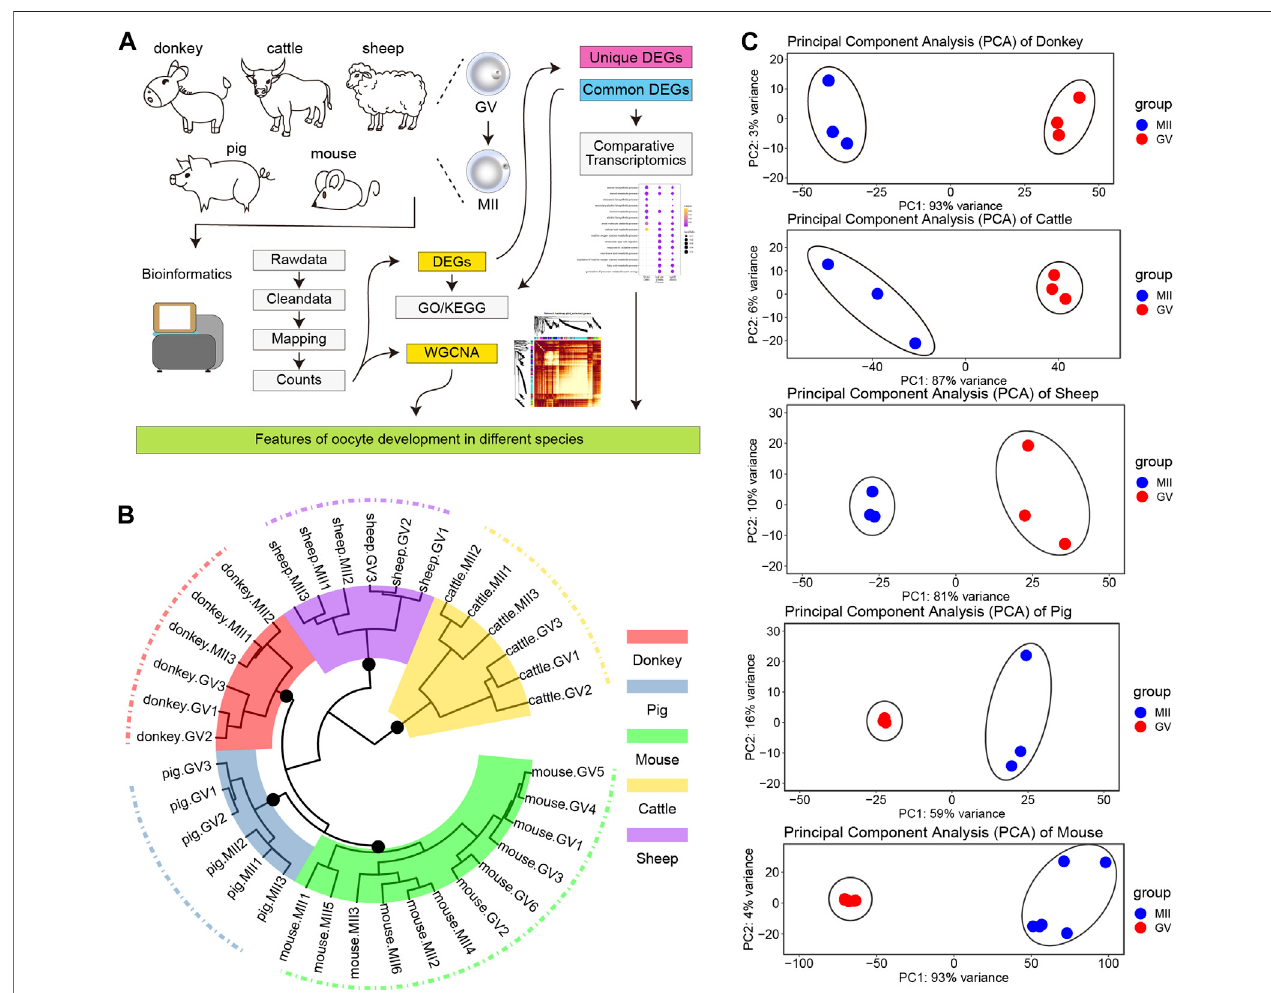
FIGURE1| Transcriptomelandscapeofoocytedevelopmentindifferentspecies. (A) Theexperimentaldesign fl owchartofthisstudy. (B) Hierarchicalclusteringof the transcriptome landscape of oocyte development in different species; different colors represent different species: red, donkey; steel blue, pig; green, mouse; gold, cattle; and purple, sheep (C) Principal component analysis (PCA) of different species; from top to bottom: donkey, cattle, sheep, pig, and mouse.